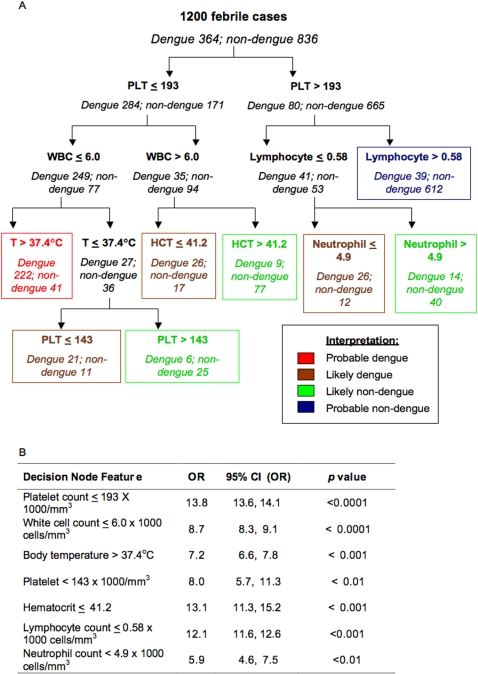
Decision algorithm for dengue diagnosis.A. Decision algorithm for predicting dengue diagnosis calculated on 1200 patients with data obtained in the first 72 hours of illness. PLT = platelet count; WBC = white blood cell count; T = body temperature; HCT = hematocrit; Lymphocyte = absolute number of lymphocytes; Neutrophil = absolute number of neutrophils. The prediction of the algorithm is shown in colours: Red indicates probable dengue; brown indicate likely dengue; green indicates likely non-dengue and blue indicates probably non-dengue. B. Statistical (chi-square) analysis of splitting criteria performed on each subgroup at the decision nodes. OR = odds ratio; CI = 95% confidence interval.